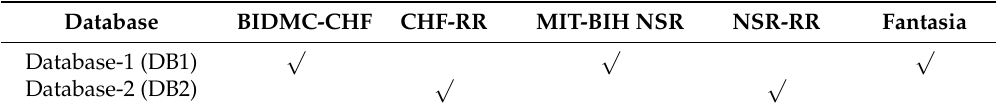
Table 3. Dataset used for comparison.